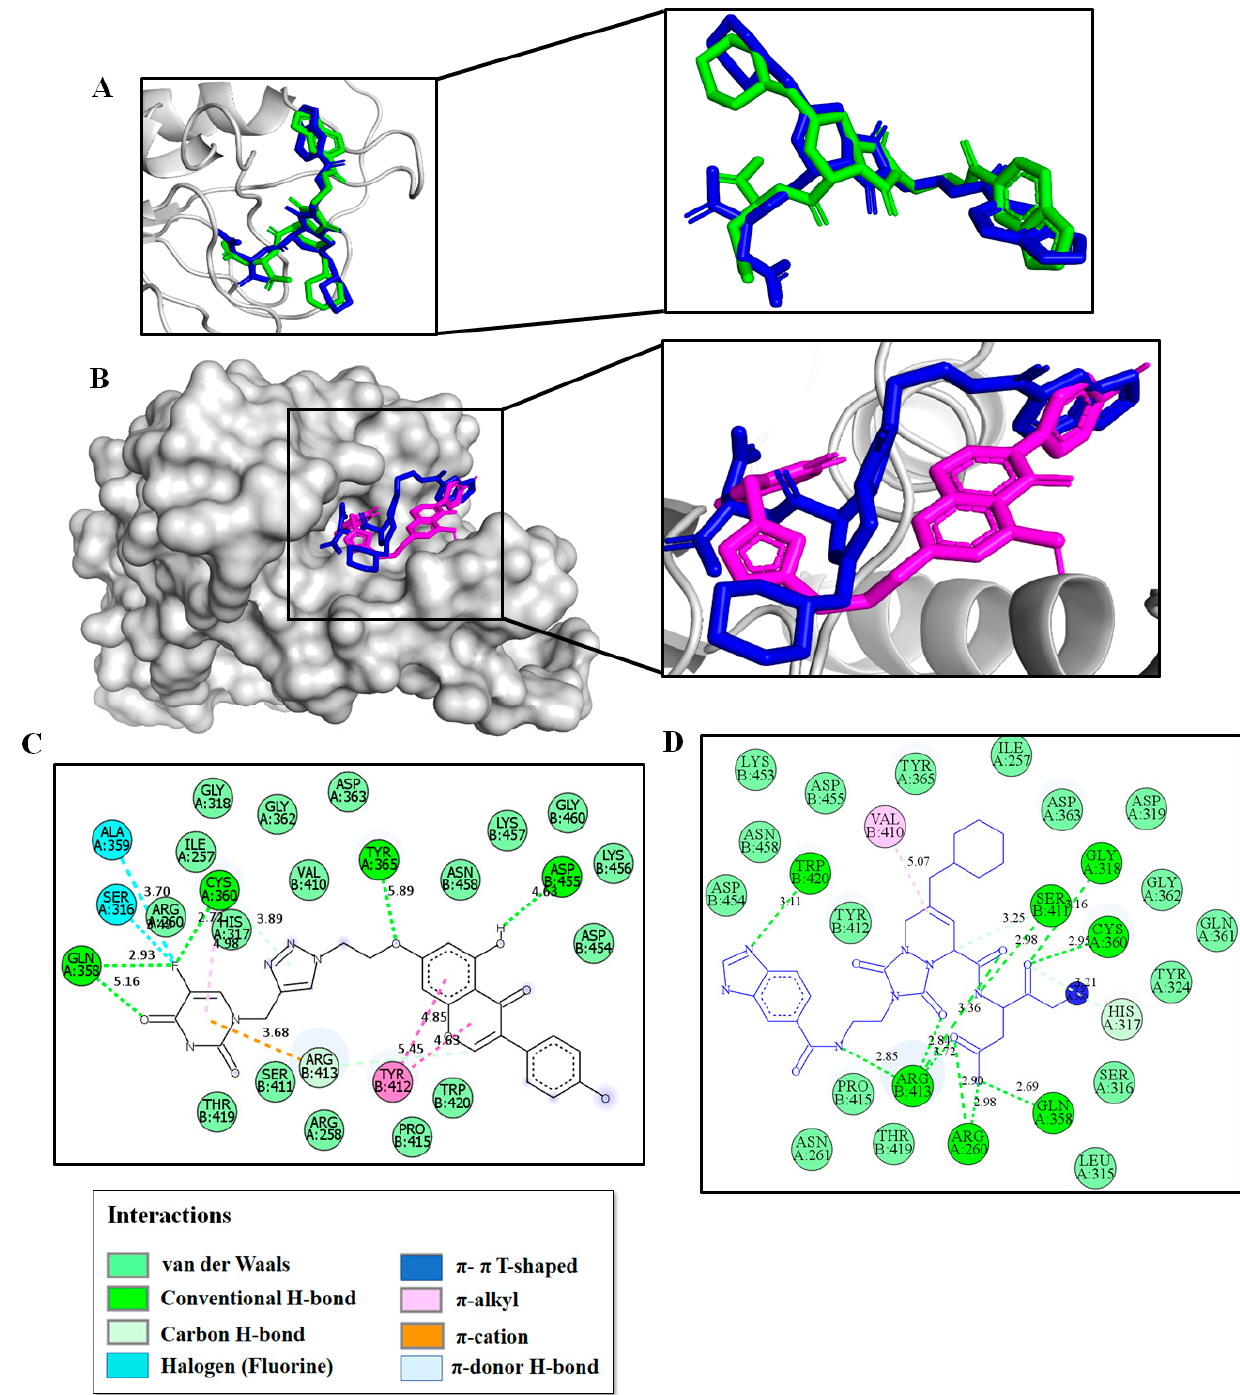
Figure 10. Docking studies of 4a-caspase-8 complex. ( A ) Self-docking study. 3D superposition of the best-docked pose of MMX-9 (in green) and its co-crystallographic binding pose (in blue). ( B ) Alignment of the best docked conformation of 4a (in magenta) and crystallographic binding mode of inhibitor MMX-9 (in blue) within the caspase-8 catalytic domain. ( C ) 2D interaction diagram between 4a and caspase-8. ( D ) 2D interaction diagram during MMX-9–caspase-8 binding. The validated docking procedure was then applied to the compound 4a (in magenta, Figure 10), which not only shows similar binding affinity ( − 8.7 kcal/mol) for caspase-8 to that inhibitor MMX-9 ( − 8.9 kcal/mol), but also is well-accommodated in the active site (Figure 10B), and similarly to the co-crystallographic inhibitor MMX-9, it interacts with